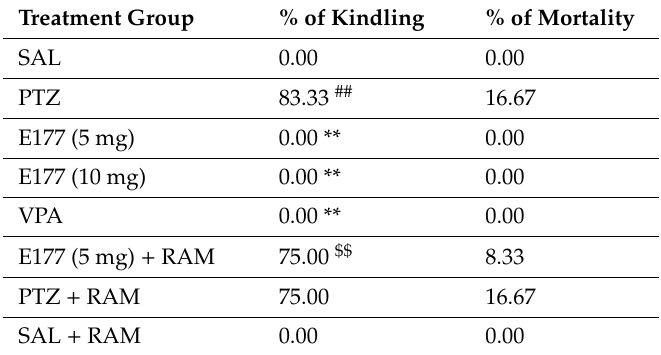
PTZ + RAM SAL+RAM 0.00 0.00 H3R antagonist E177 (5 and 10 mg/kg) and VPA (300 mg/kg) were injected 30 ‐ 45